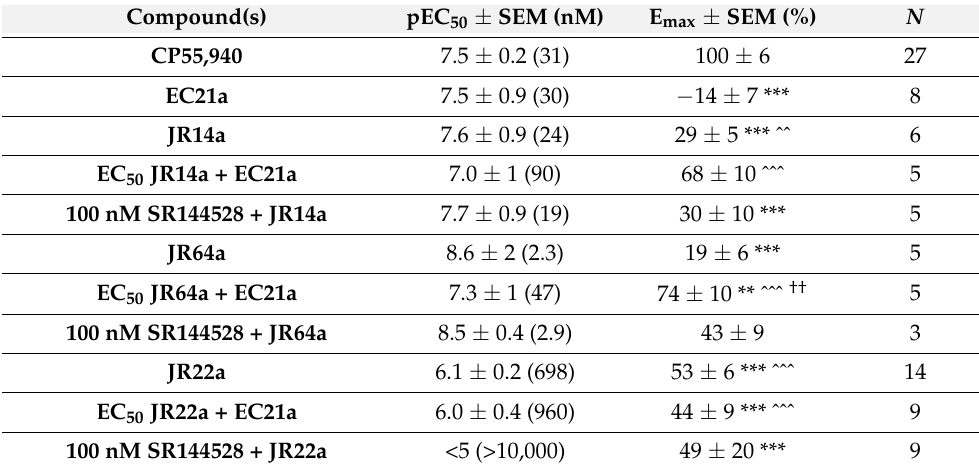
Table 1. Inhibition of Forskolin-Stimulated cAMP.